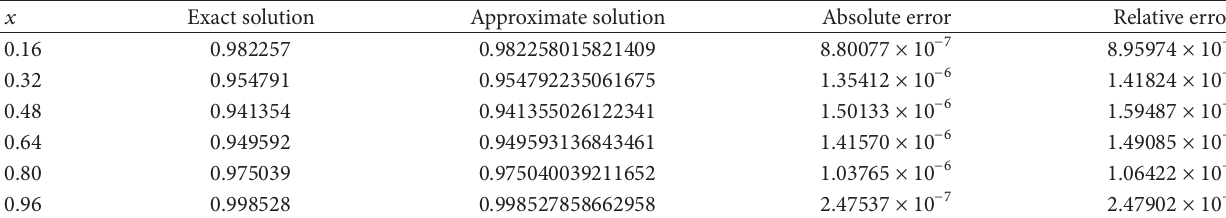
Table 5: Numerical results of 𝑢 2 (𝑥) for Example 2.